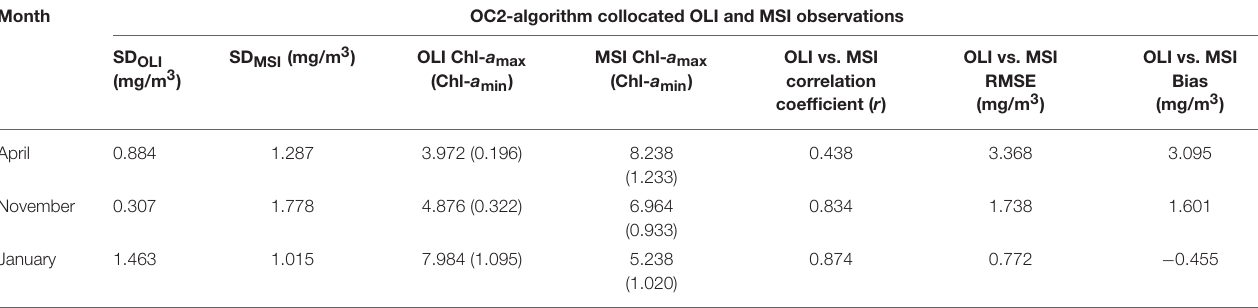
MSI Chl- a max (Chl- a min )